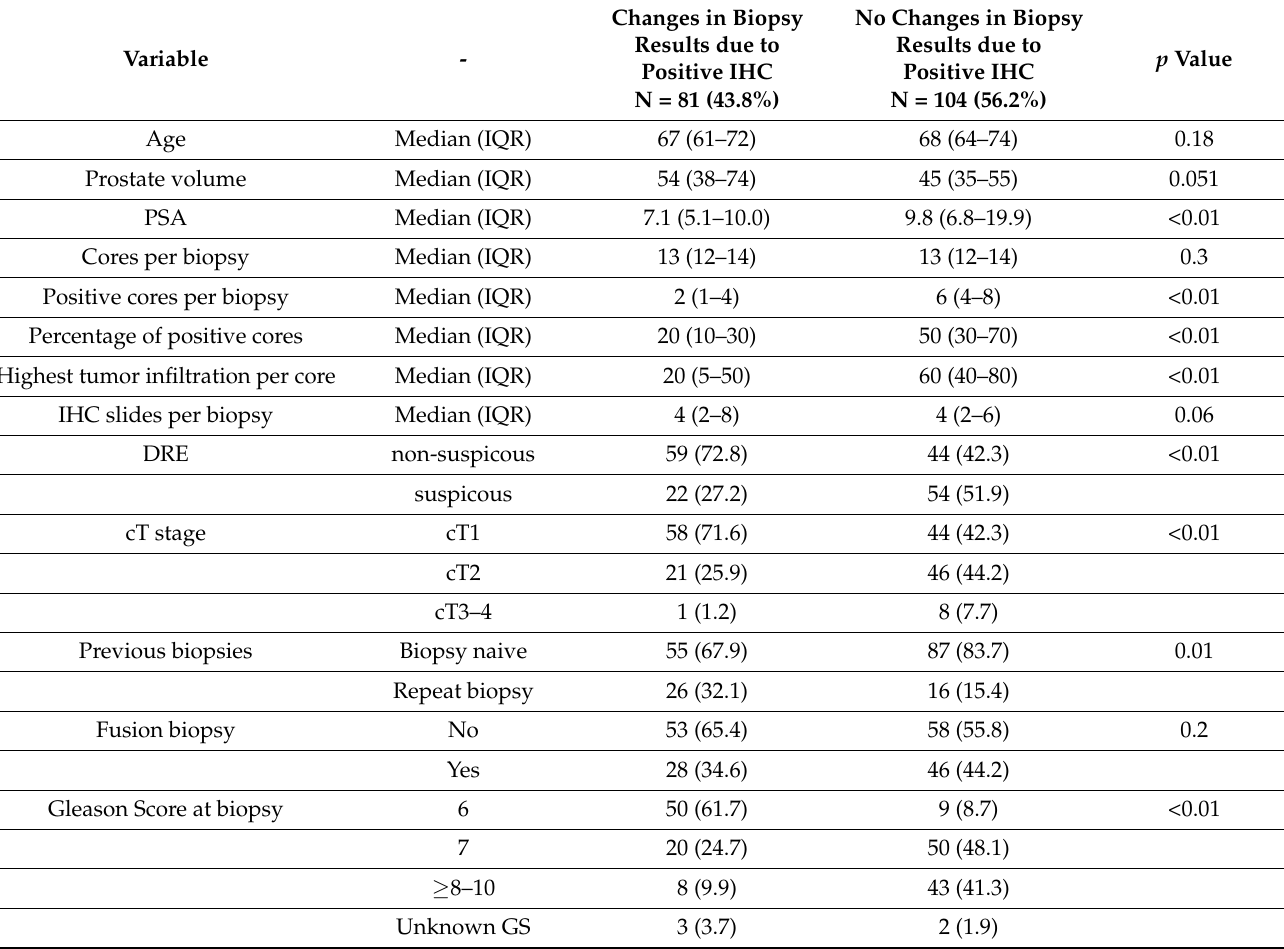
Table 2. Descriptive analyses of 185 patients with positive prostate biopsy and histological positive immunohistochem- istry (IHC) at University Hospital Frankfurt between 01/2017–06/2020, stratified according to changes in biopsy results due to positive IHC results or not. Abbreviations: PSA—prostate-specific antigen; DRE—digital rectal examination; GS: Gleason score.